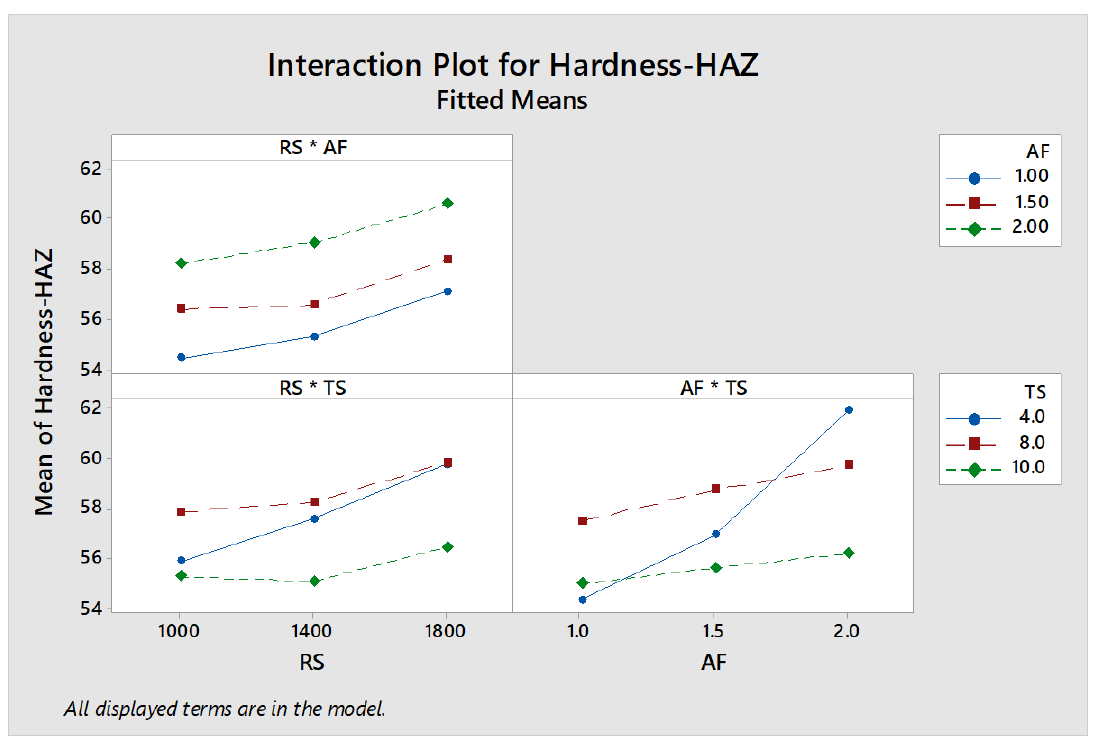
Figure 24. Interaction effects plots — hardness in HAZ.